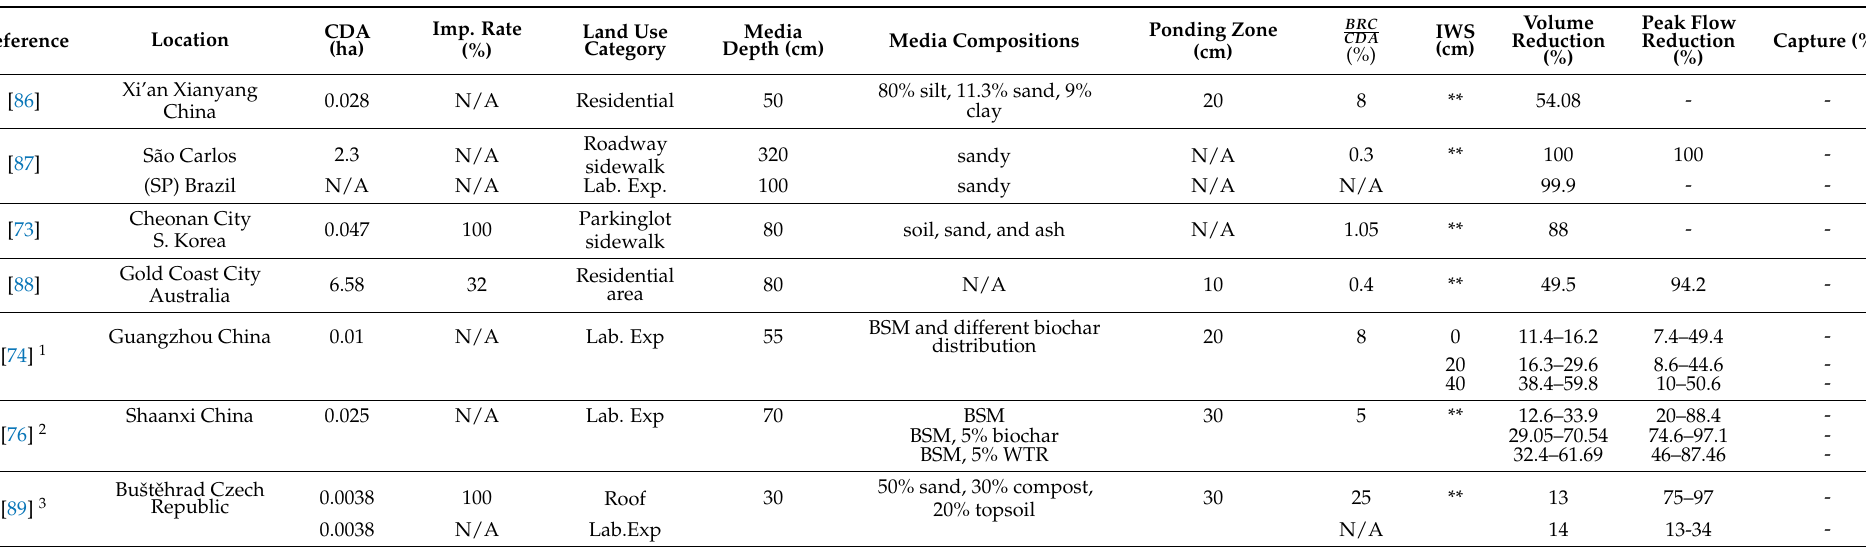
Table 4. The hydrologic performance, volume reduction, peakflow reduction, and capture of the BRC literature studies in China, Brazil, Australia, South Korea, and Czech Republic. For each study, the site characteristics, including the contribution drainage area (CDA), imperviousness rate (Imp.Rate), and land use category, are reported together with the system characteristics, including media depth and composition, ponding zone, fraction between the BRC and contribution drainage areas(BRC/CDA), and the internal water storage